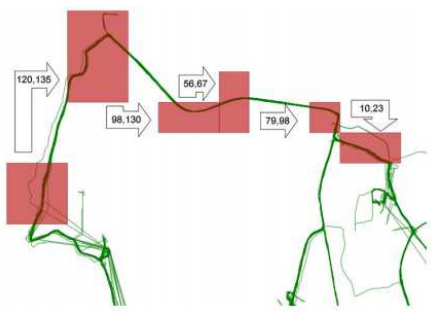
Fig. 10 Example of T-pattern in temporally annotated trajectory [53] .